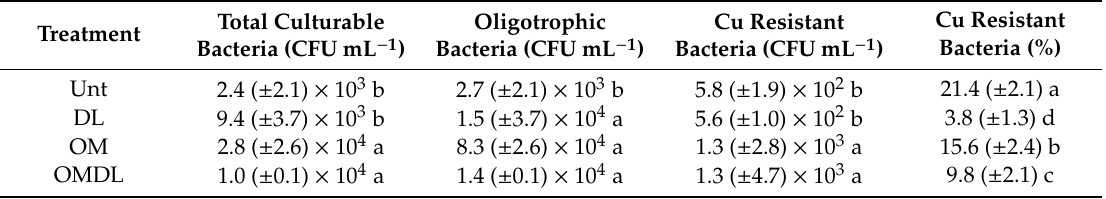
Values are the average of three replicates, and values in brackets are the standard deviation of the means. Values followed by the same letter(s) are not significantly different at p value 0.05 by ANOVA and the Fisher HSD test.